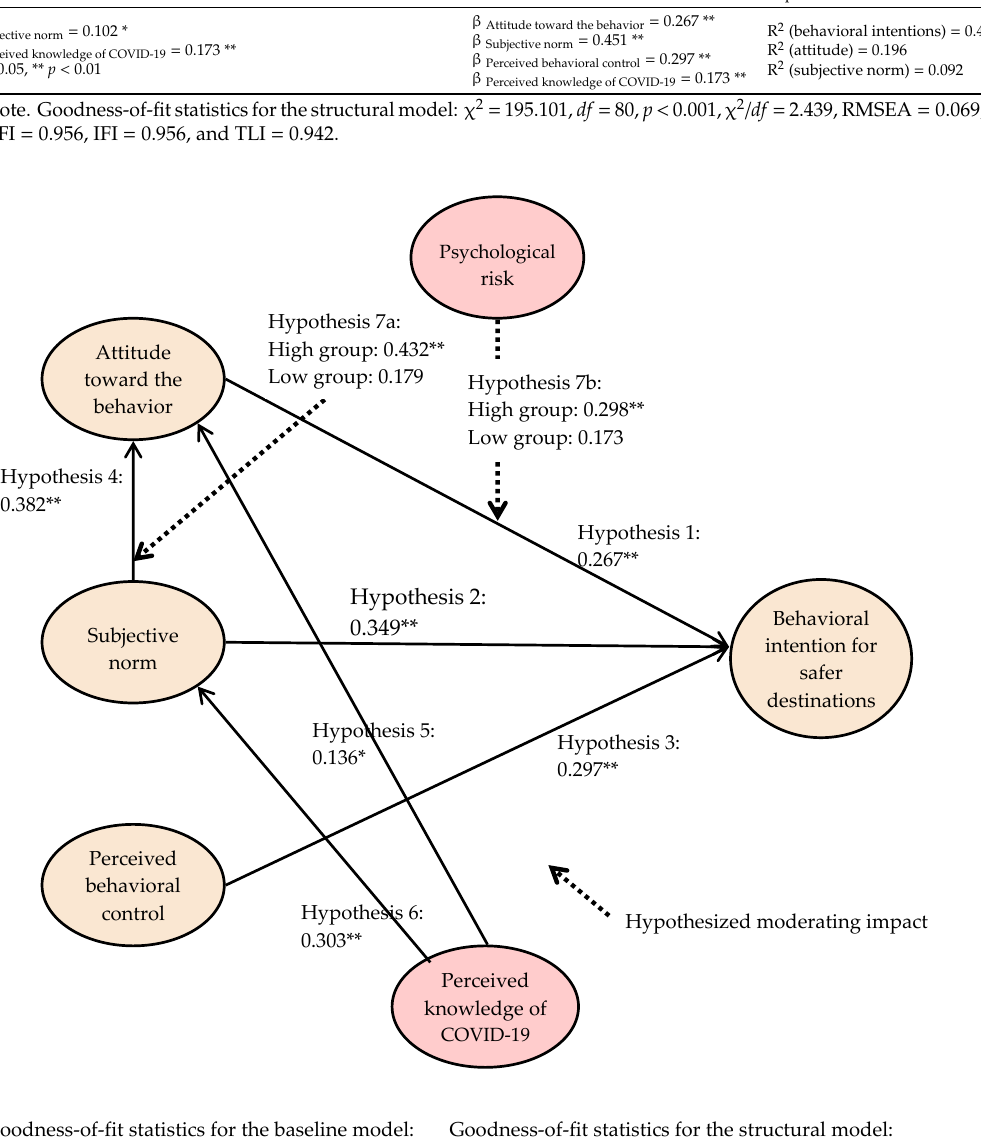
Figure 3. Proposed model evaluation results.